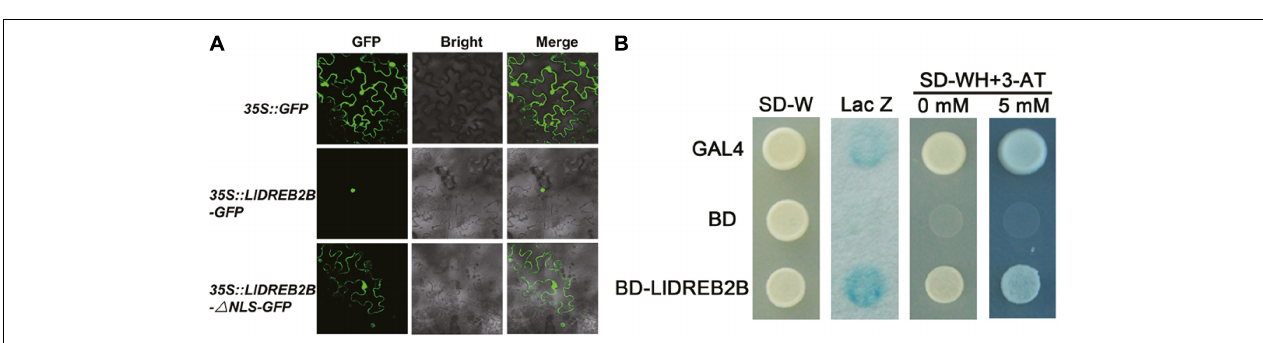
FIGURE 3 | Analysis of LlDREB2B expression and promoter activity under different abiotic stresses. Relative expression in leaves after (A) 3 h under different ambient temperature treatments, (B) exposure to 37 ◦ C for different lengths of time, and (C) treatment of tissue-cultured lily seedlings by placing their roots in water (CK), salt solution (NaCl, 200 mM), or mannitol solution (400 mM) for 24 h. For cold treatments, lily seedlings were treated for 24 h at 4 ◦ C. Lily 18S rRNA was used for data normalization. Each treatment included three plants. Bars are means ± SD of three independent experiments. (D) Histochemical analysis of GUS activity in 7-day-old transgenic seedlings grown under normal conditions and treated at 37 ◦ C for 3 h. (E) GUS analysis of seedlings treated with water (control), salt solution (NaCl, 150 mM), mannitol solution (300 mM), or cold (4 ◦ C) for 12 h, or HS (37 ◦ C) for 3 h. Three independent experiments were performed, and one representative is shown.